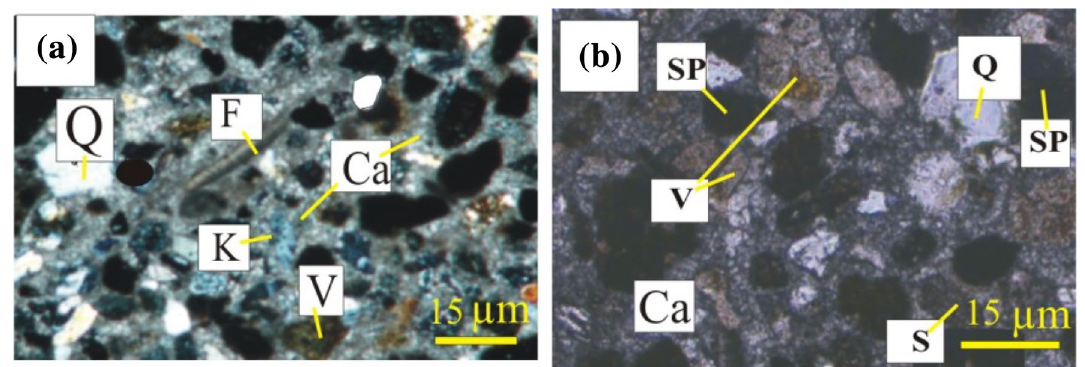
Fig. 3 Micrographs of the Kömürlü Formation sandstones. a Carbon- ate cement (Ca) is seen. Q quartz, K quartzite, F fossil, V volcanic rock, depth: 2365 m, sample 3. b Secondary porosity (SP) is observed via dissolution of the carbonate cement (Ca). Lithic arenite [closely